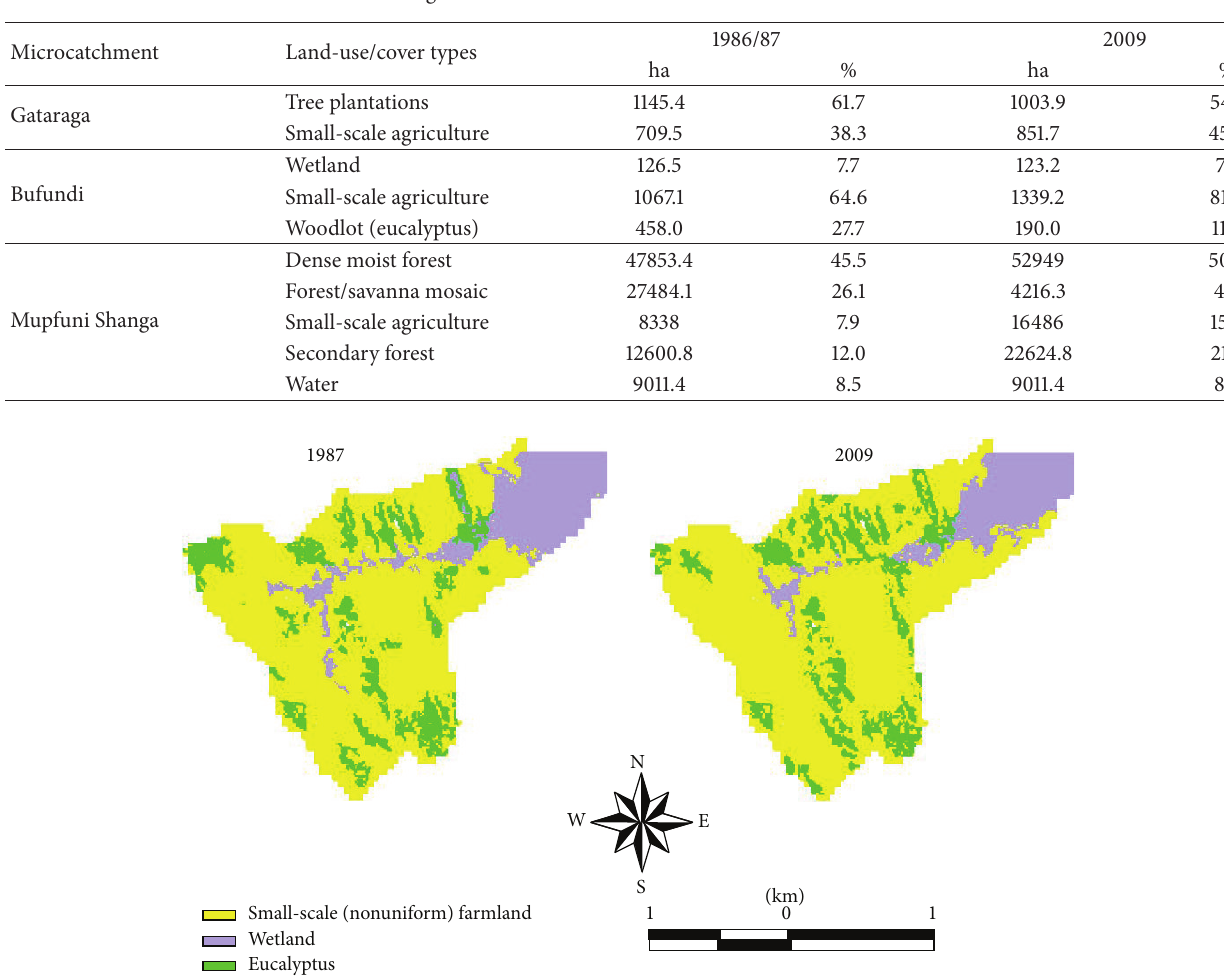
Table 1: Area coverage of the dominant land-use/cover of selected areas of the LK PLS.